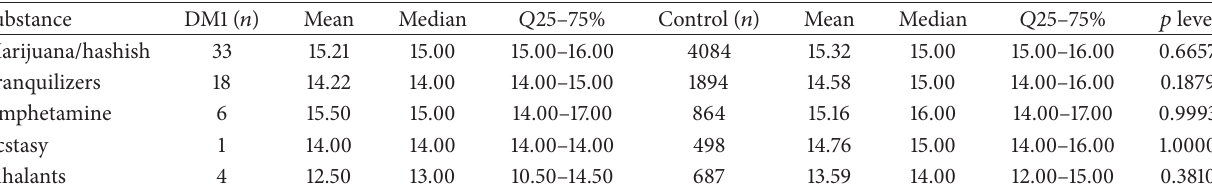
Table 3: Initiation time of illicit drugs use in years of